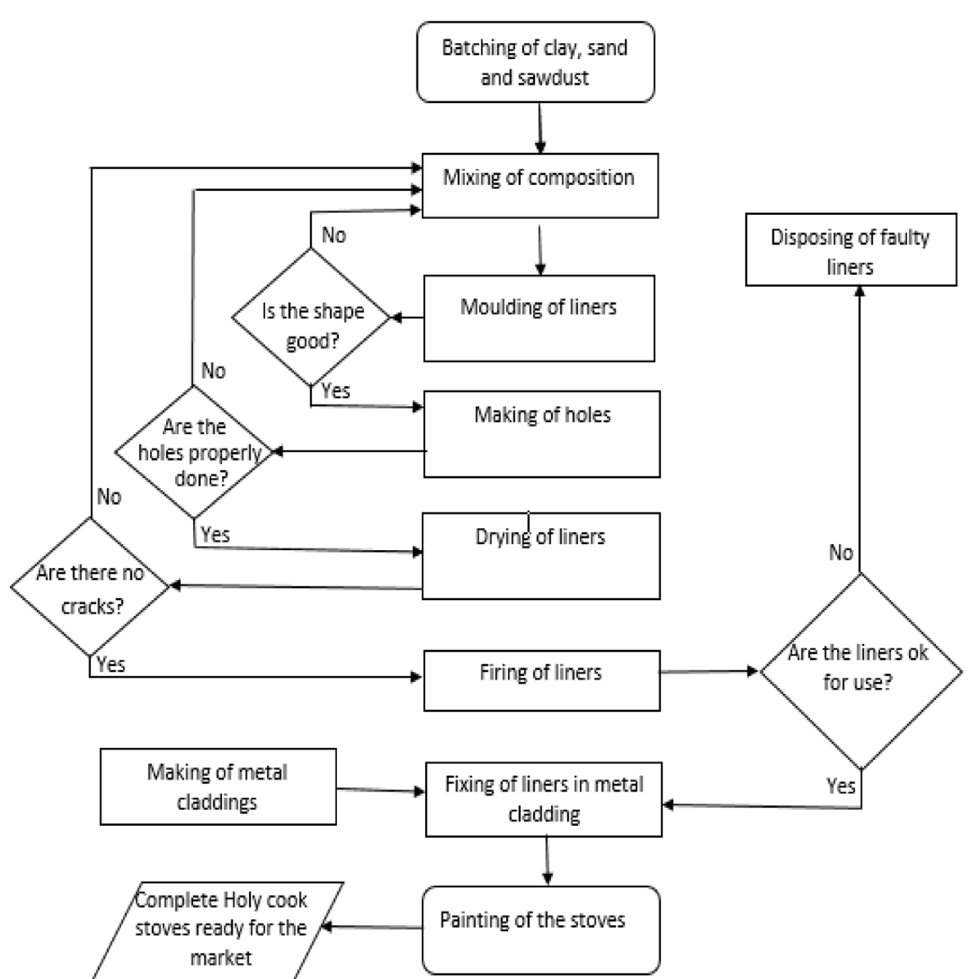
Fig. 2. Flow chart indicating the production processes of the ceramic liner. Source: Authors own construct